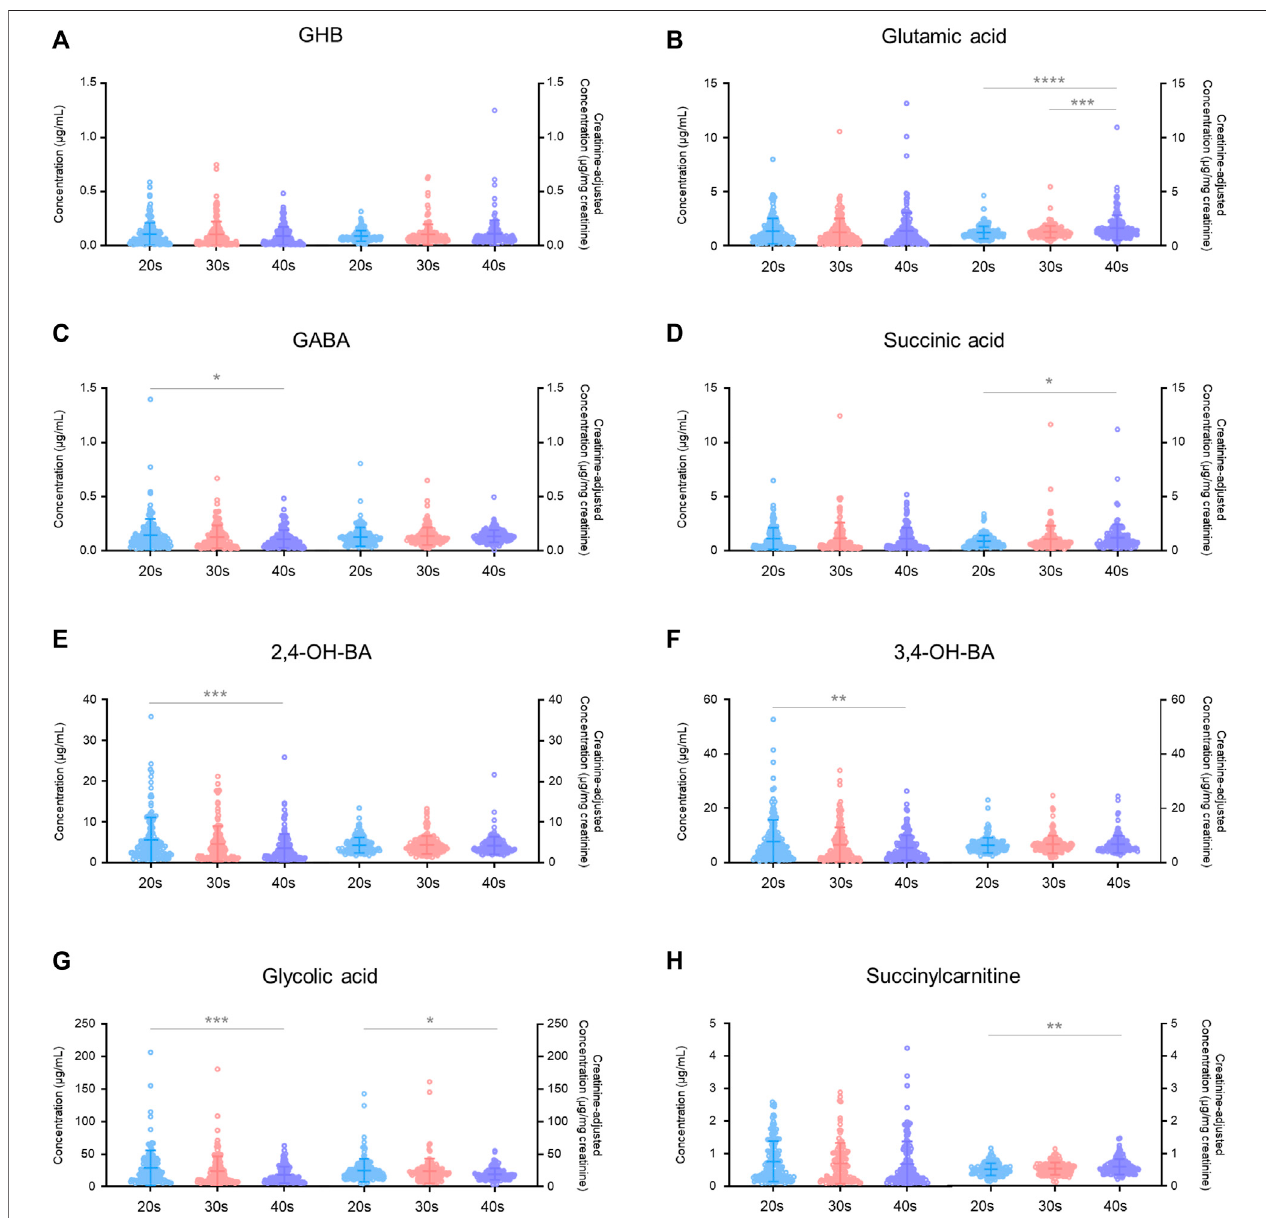
FIGURE3| Age-dependent variabilitiesinunadjustedandcreatinine-adjustedconcentrationsofGHB (A) ,glutamic acid (B) , GABA (C) ,succinic acid (D) ,2,4-OH- BA (E) ,3,4-OH-BA (F) , glycolic acid (G) , and succinylcarnitine (H) in 472urine samples. Horizontal lines within the scattered dots indicate means ± standard deviations. Values less than the limit of quanti fi cation were excluded. * p < 0.05, ** p < 0.01, *** p < 0.001, **** p < 0.0001.